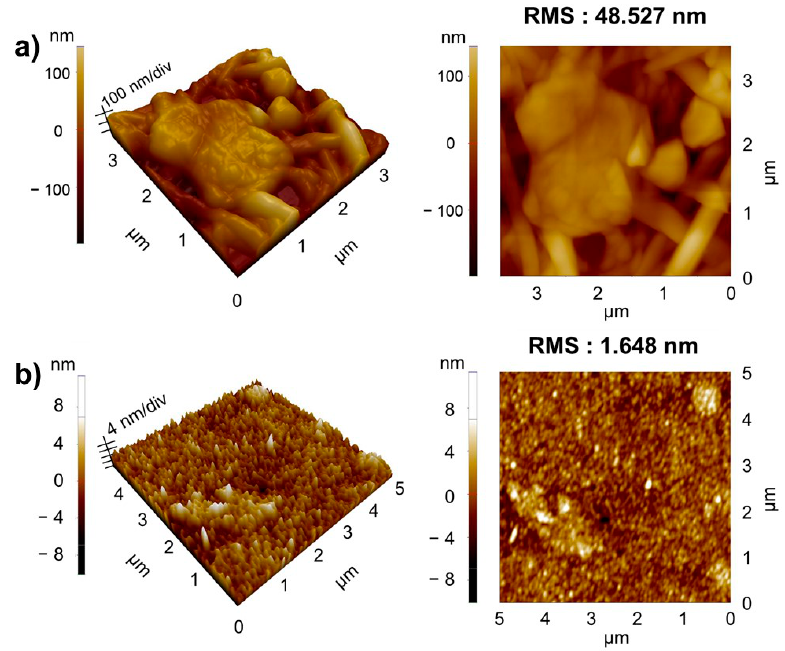
Figure 3. AFM images. ( a ) GCA/AgNW/PET electrode, ( b ) GCA/AgNW/GCA/cPAI electrode.